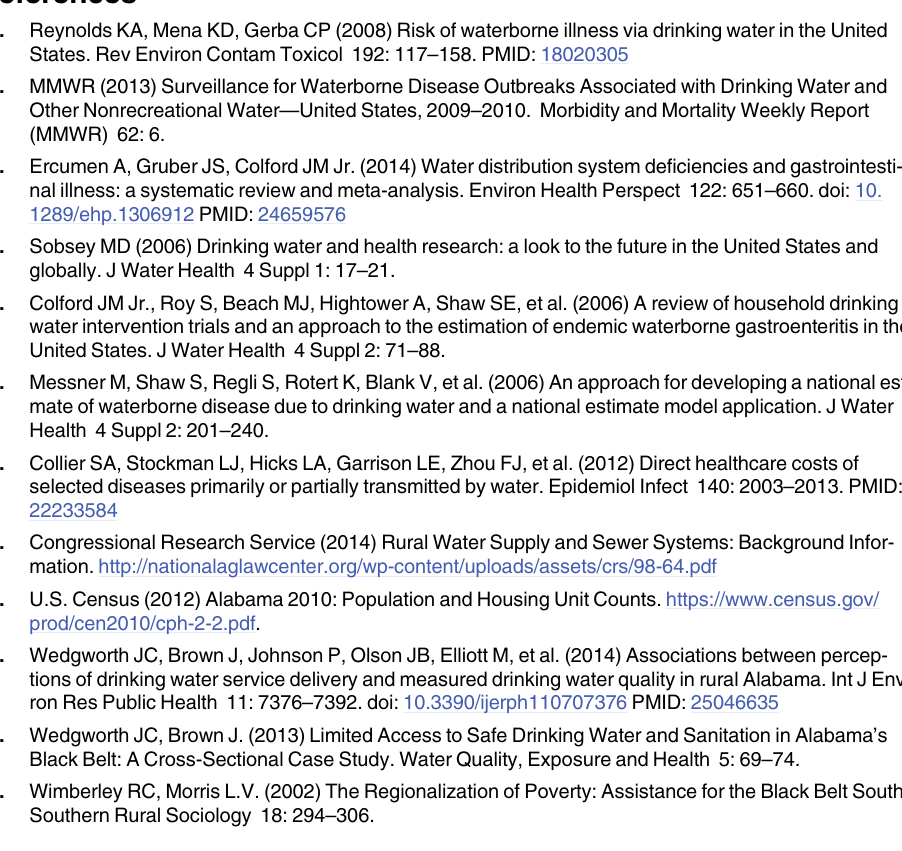
S1 Table. Description of variables used in